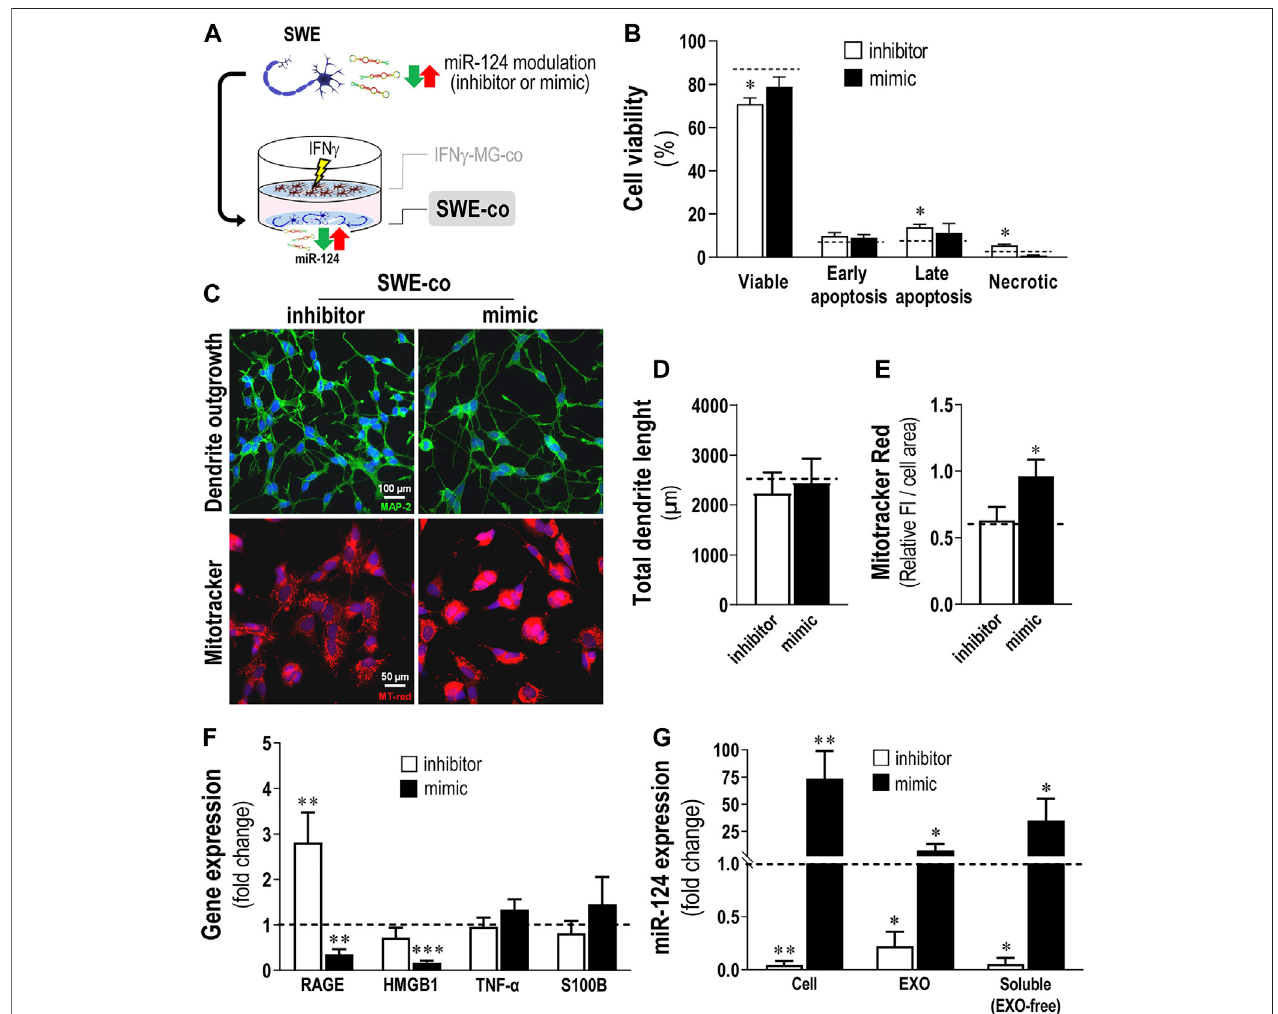
FIGURE 4 | InhibitionofmiR-124inSWEcellsincreasescelldeathandRAGEgeneexpression,whilethemimicenhancesMitoTrackerRedintensityandmiR-124cargoin cells and their secretomes, together with a reduction of stress-associated genes, upon coculture with IFN γ -MG. After differentiation, SWE cells were transfected with miR124 inhibitorandmimic,whileCHME3microglia(MG)weretreatedwithIFN γ for24 hbeforecoculture(IFN γ -MG),asdetailedin MaterialsandMethods . (A) Schematicrepresentationof themiR-124modulation,followedbythecocultureestablishmentwithIFN γ -MG. (B) CellviabilityofSWEcellsincoculturewithIFN γ -MG,assessedbyNexin fl owcytometry assay. Four cell populations were distinguished: viable (V-PE and 7-AAD double-negative), early apoptotic (V-PE positive and 7-AAD negative), late apoptotic (V-PE and 7-AAD double-positive),andnecroticcells/cellulardebris(V-PEnegativeand7-AADpositive). (C) Representative fl uorescenceimagesofMAP-2(green)andMitoTracker(red)inSWEcells uponcoculturewithIFN γ -MG, (D) respectiveevaluationoftotaldendritelength,and (E) quanti fi cationofMitoTracker fl uorescenceintensity(FI). (F) In fl ammation-associatedgene expressionlevelsinSWEcellsuponcoculturewithIFN γ -MG. (G) Quanti fi cationofmiR-124expressionlevelsinSWEcellmonocultures,aswellasexosomes(EXOs)andexosome- free (EXO-free, soluble) secretome, 24 h after transfection with the miR-124 inhibitor and mimic vs . respective mock controls (dashed line). Results are mean ± SD from at least threeindependentexperiments.* p < 0.05,** p < 0.01,and*** p < 0.001 vs .mockcontrol(dashedline),one-wayANOVAwiththeBonferroni posthoc test.SWE,humanSH-SY5Y expressingtheAPP695Swedishmutantprotein;IFN γ -MG,IFN γ -stimulatedCHME3humanmicrogliacells;co,cocultured;miR,miRNA;RAGE,receptorforadvancedglycation end products; HMGB1, high mobility group box 1; TNF- α , tumor necrosis; S100B, S100 calcium-binding protein B; EXO,